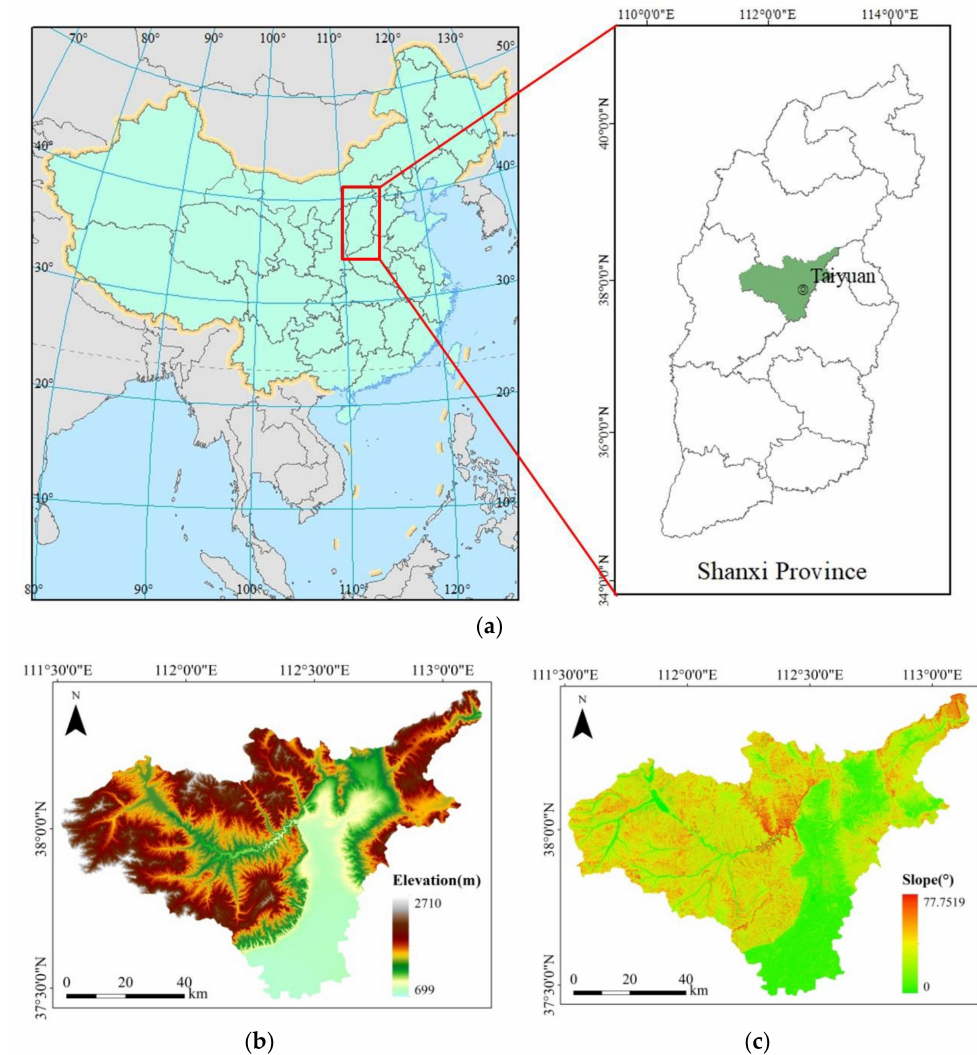
Figure 1. Research area. ( a ) Location of the research area; ( b ) DEM of the research area; ( c ) Slope map of the research